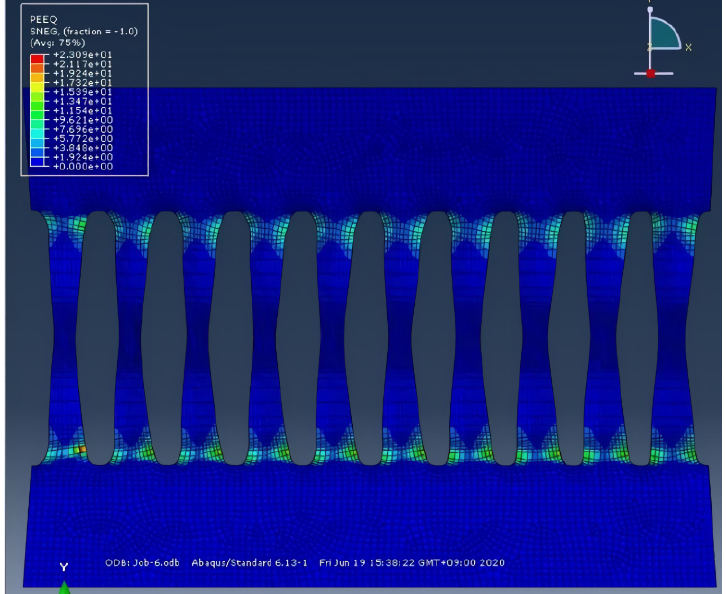
Figure 8. Plastic strain accumulation of steel shear panel damper.